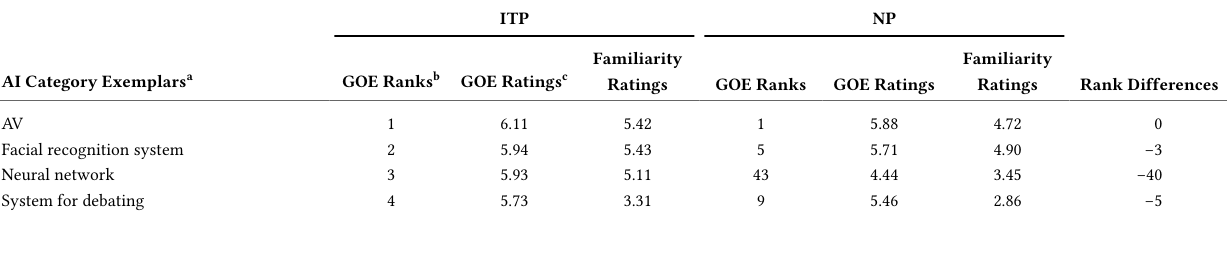
Comparison of Typicality and Familiarity Assessments of the AI Exemplars for IT-Professionals (ITP) and Non-Professionals (NP)